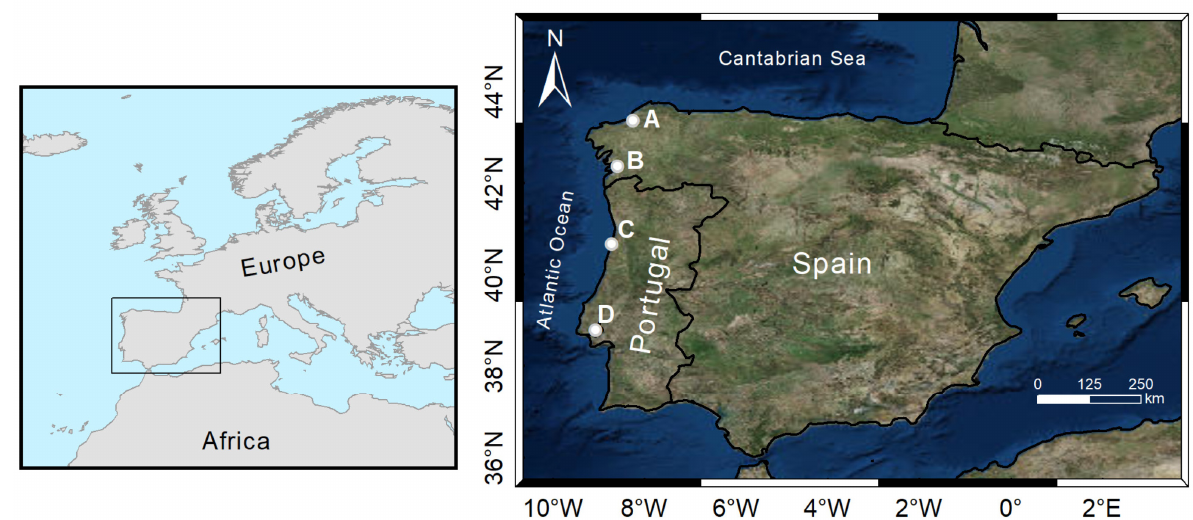
Figure 1. NW Iberian Peninsula. White circles are the locations of the ports considered for this study. ( A ) A Coruña Outer Port (43.35° N, 8.51° W), ( B ) Vigo (42.23° N, 8.74° W), ( C ) Aveiro (40.64° N, 8.75° W), and ( D ) Lisbon (38.70° N, 9.17° W).